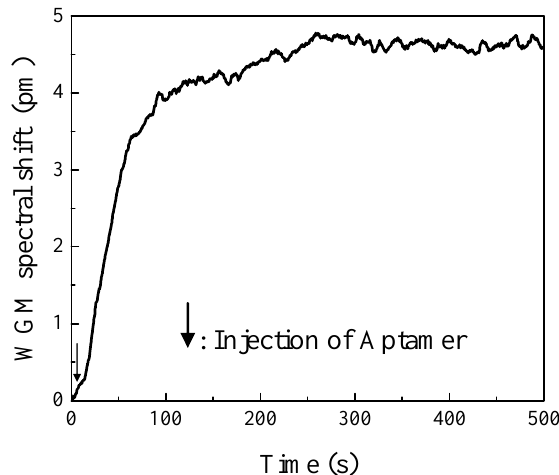
Figure 3. Sensorgram of a microsphere resonator when aptamer molecules bind to the silanized sphere surface via PDC. The total WGM shift due to aptamer binding is 4.1 pm, corresponding to an aptamer surface density of 3 x 10 12 /cm 2 . Arrow indicates when aptamer solution is added. Aptamer concentration is 0.5 mM. Sphere size: R = 125 µ